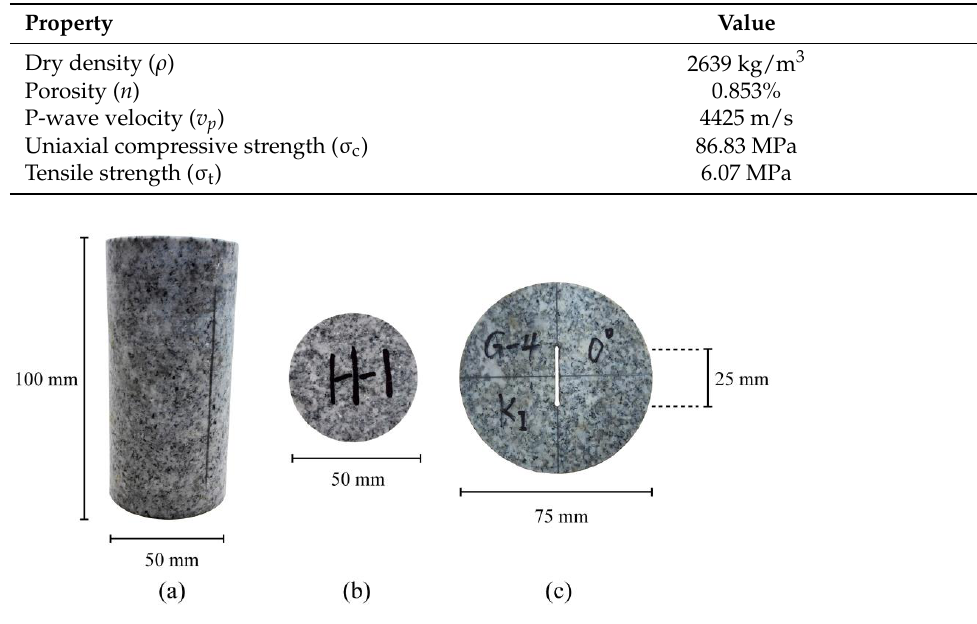
Figure 2. Granite specimens used in the experiments: ( a ) cylinder specimen for uniaxial compres- sion tests; ( b ) disc specimen for Brazilian tests; ( c ) cracked-through Brazilian discs (CSTBD) spec- imen for fracture toughness tests.